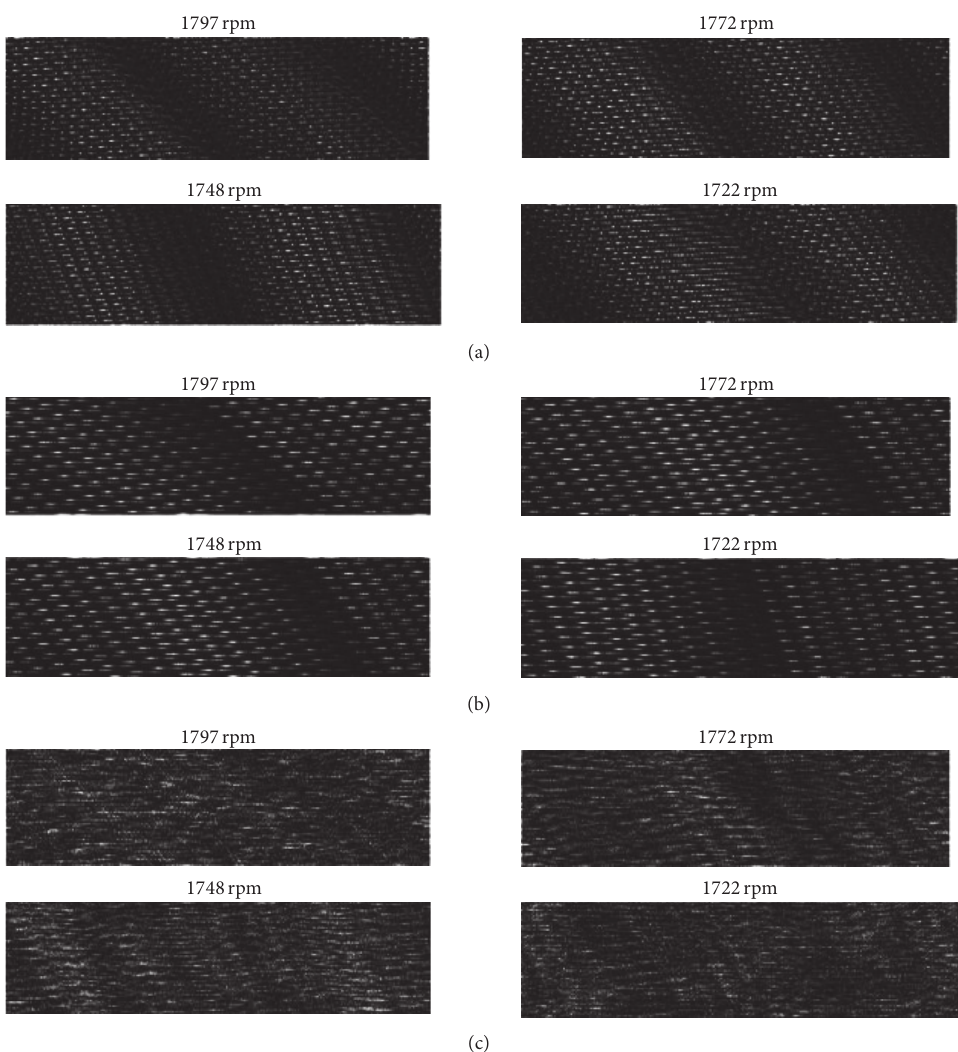
Figure 4: The vibration images for (a) the inner race fault, (b) the outer race fault, and (c) the ball fault.